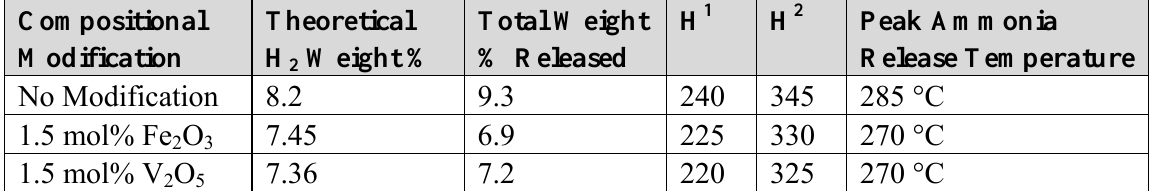
Table 2. Summary of TGA/RGA decomposition data of the as-milled samples without and with